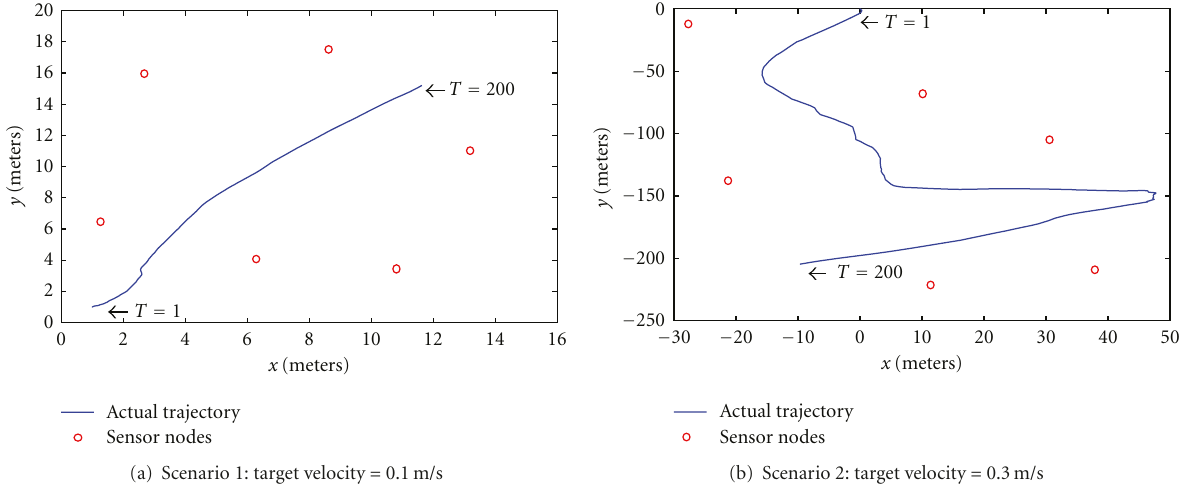
Figure 3: Actual track of the target with di ff erent velocity.